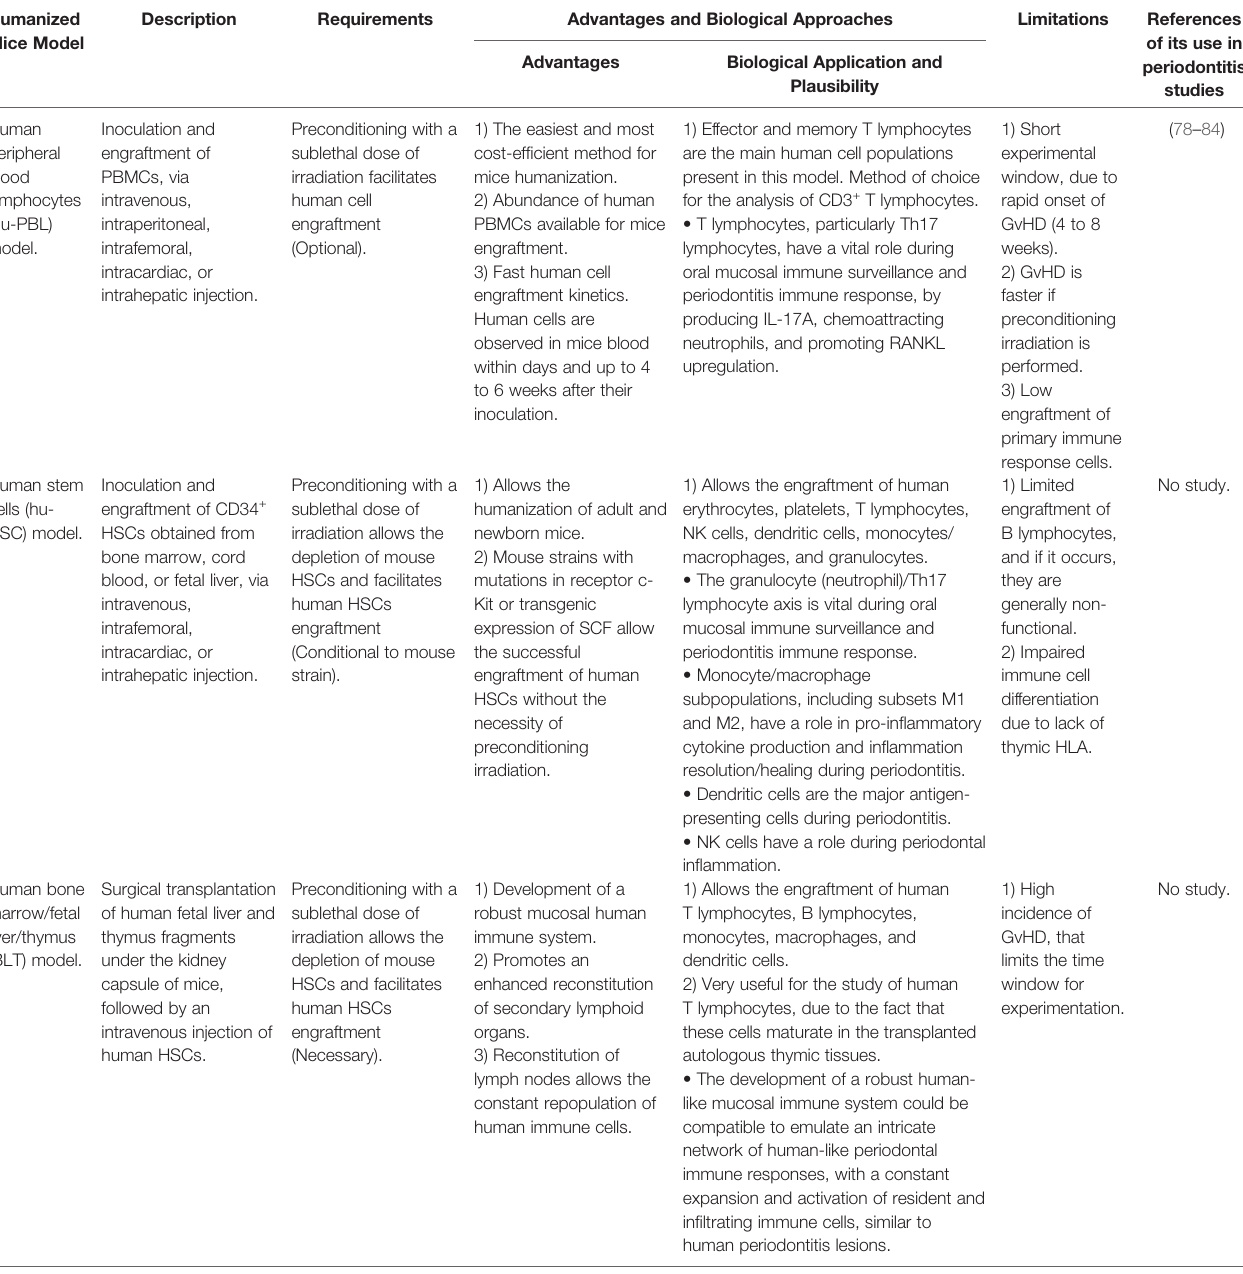
TABLE 2 | The most widely used models for mice